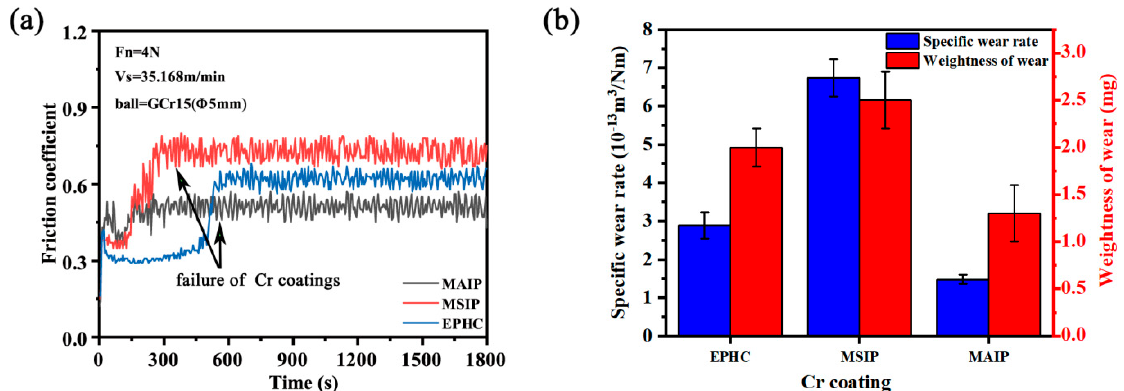
Figure 8. ( a ) The friction coe ffi cient of the three chromium coatings; ( b ) speci fi c wear rate and weight of wear of the three chromium coatings.